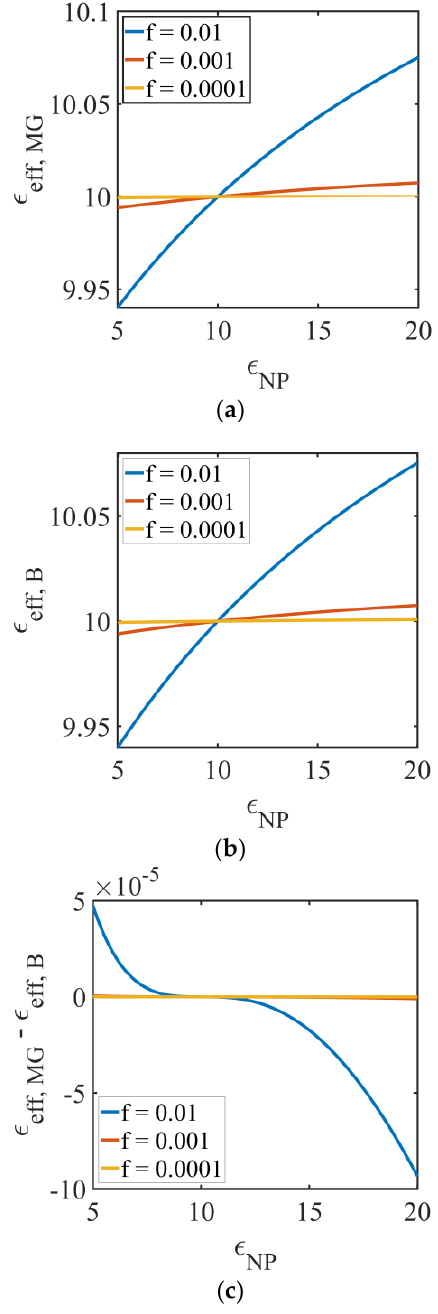
Figure 6. Representation of effective permittivity for NPs-doped LC versus NP permittivity, ε NP , for three NP volume fractions: 0.01; 0.001; and 0.0001, ( a ) MG model (Equation (14)); ( b ) Bruggeman model (Equation (15)), and ( c ) the difference of the effective permittivity obtained using these models. Comparing the two models, Figure 6c shows the difference ε ef f , MG − ε ef f , B for the NPs-doped LCs. It results that ε ef f , MG > ε ef f , B , when ε NP < 10 (which corresponds to ε NP = ε LC ) and then it changes its sign, the difference being noticeable at NP volume fraction of 0.01, but still of the order of 10 − 4